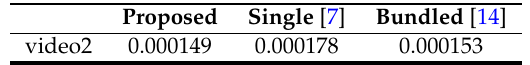
Table 5. Perspective distortion of the various video stabilization methods.